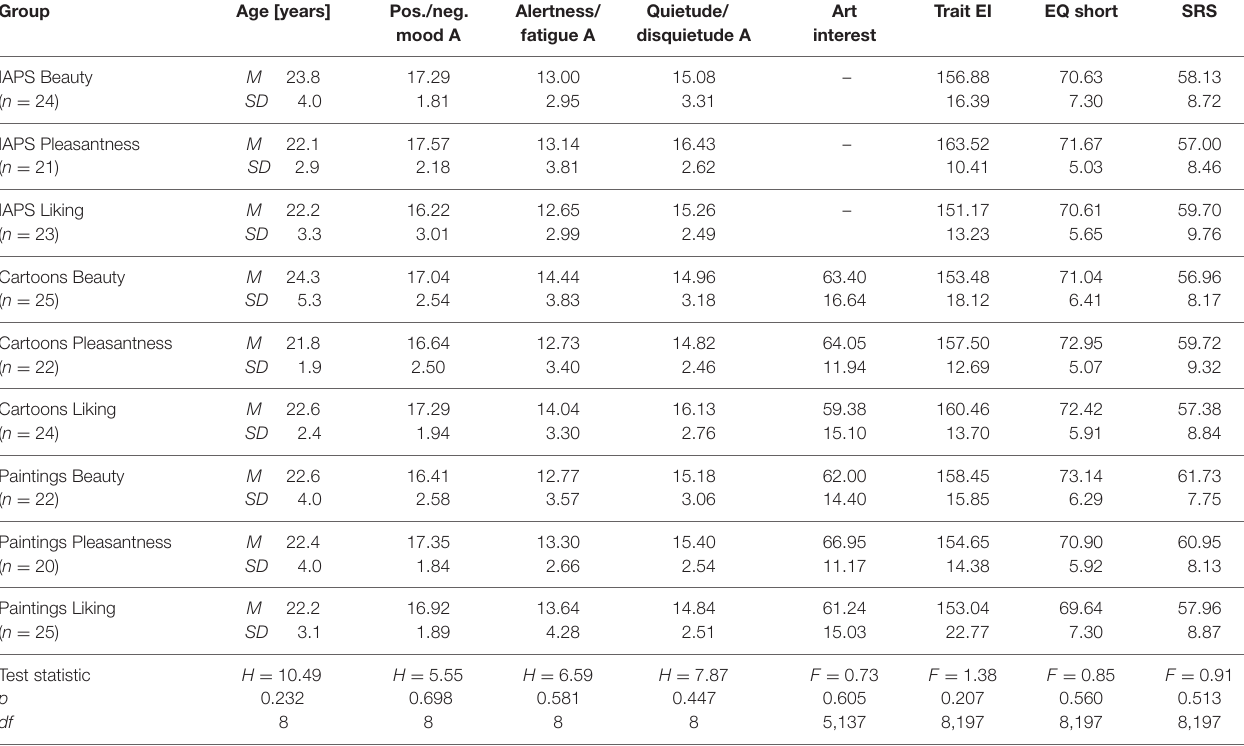
TABLE 1 | Participant